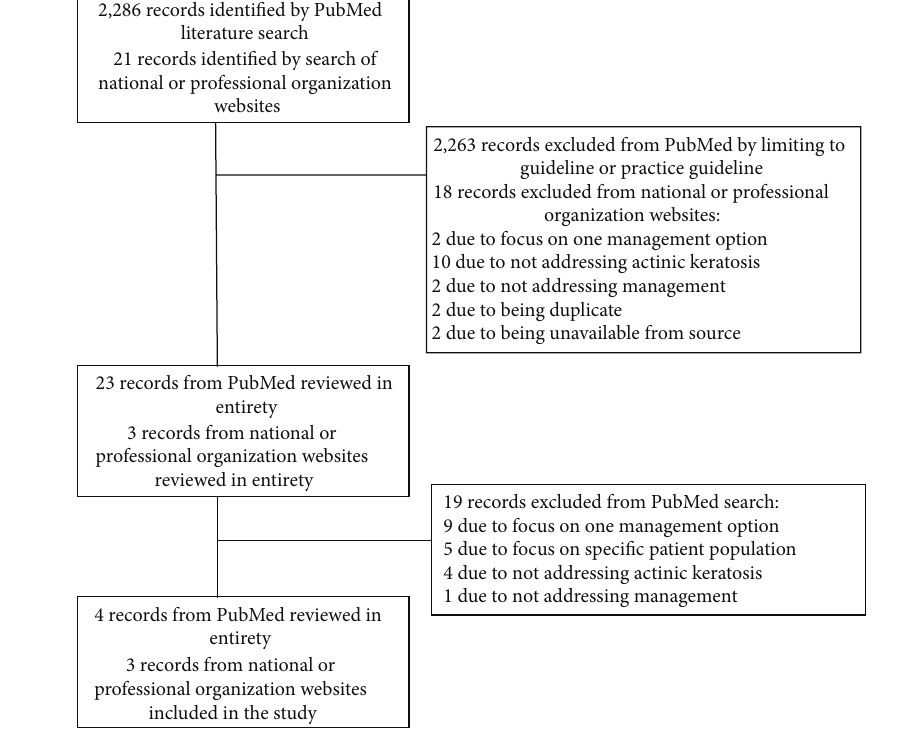
Figure 1: Literature search and study selection process. Table 1: Characteristics of the included